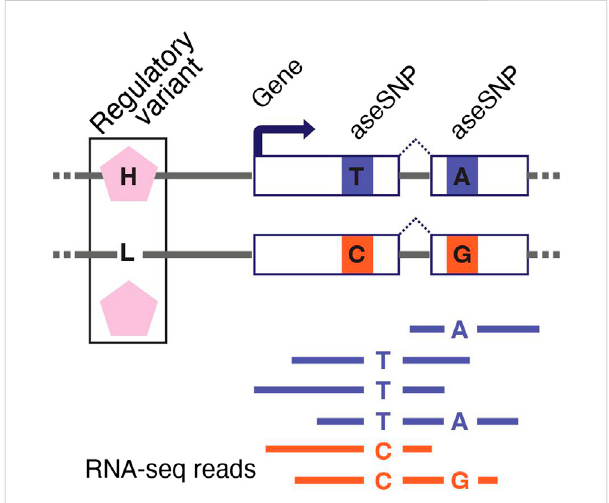
FIGURE 3 Measuringallele-speci fi cexpressionwithRNA-seq.RNA-seqcan be used to generate allele-speci fi c expression (ASE) data for genes with a heterozygous single-nucleotide polymorphism in the transcribed region (aseSNP). The aseSNP enables sequencing reads to be mapped to the haplotype from which they originate. Imbalance in ASE data is a functional indicator of a cis-regulatory difference between the two haplotypes that is driven by heterozygous regulatory variants. Data from multiple aseSNPs can be aggregated to improve ASE data quality. The non-coding regulatory variant